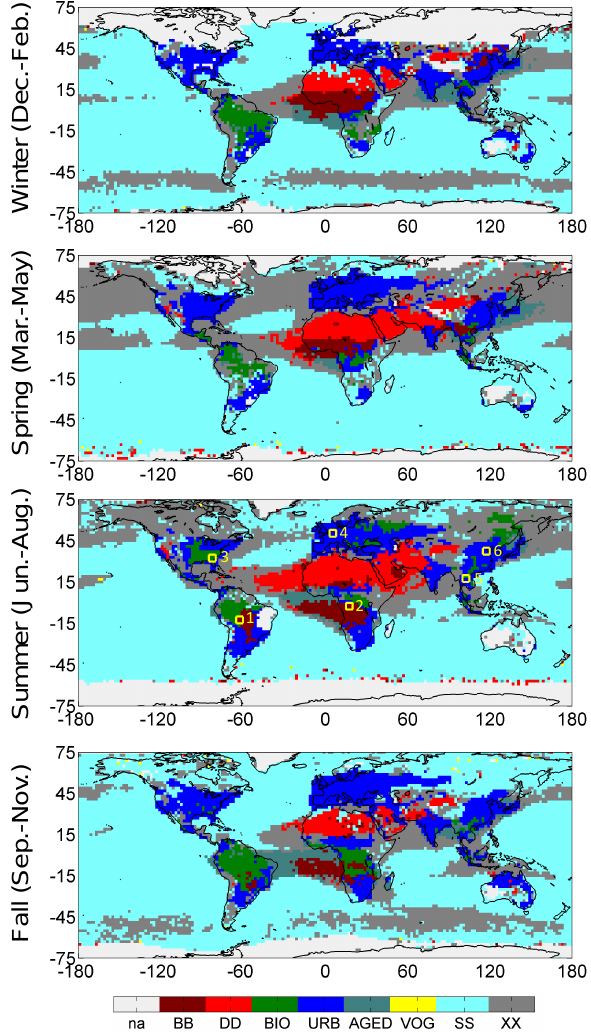
Figure 6. Seasonal cycle of global main aerosol source distribution according to GACA. Data are from 2007–2011 and were divided into the four main seasons (from top to bottom): winter, spring, summer, and fall. Aerosol source type abbreviations are given in Table 2; gray areas are not analyzed due to lack of data or too small mean AOD (see text for details). Enumerated yellow boxes in the third panel mark the regions investigated in Figs. 10–12, respec-